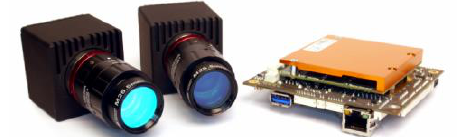
Figure 2 . The HyperView multi sensor hyperspectral system